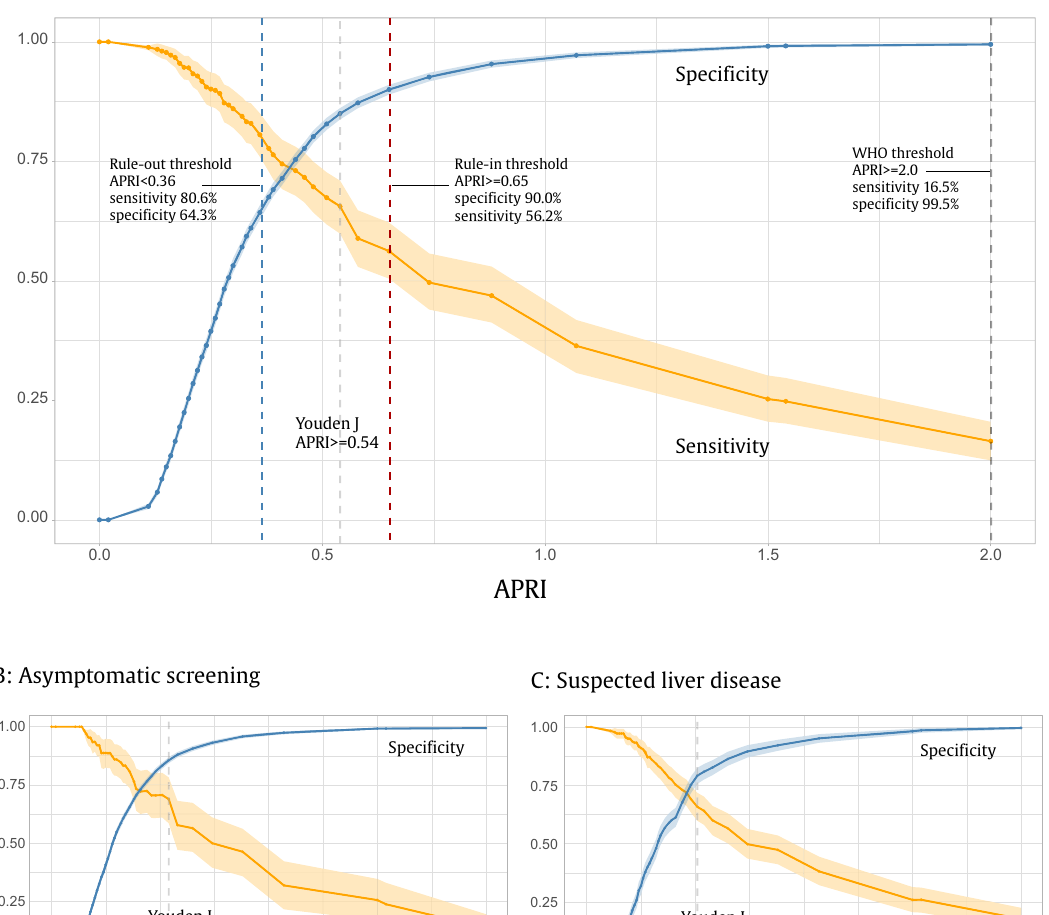
bands. a Bayesian bivariate random effects model fi tted for different thresholds of APRIusing60equallyspacedquantiles.Speci fi cityisde fi nedastheprobabilityofa negative test given the absence of LSM>12.2; sensitivity is de fi ned as the prob- abilityofapositivetest,giventhepresenceofLSM>12.2.Sourcedataareprovided as a Source Data fi